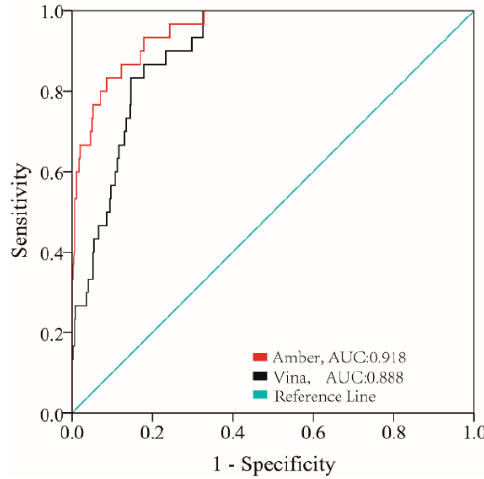
Figure 2. Receiver operating characteristic (ROC) analysis of the simulated docking model.